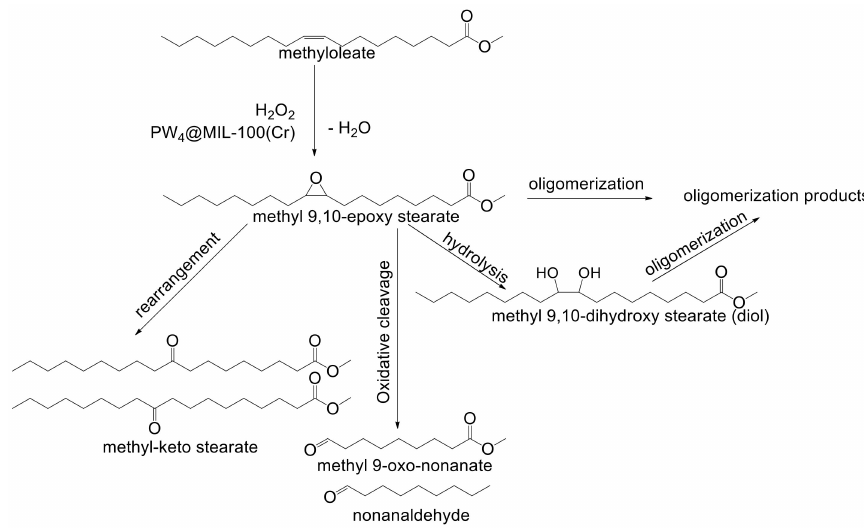
Figure 4. The proposed scheme of the reactions occurring during the epoxidation of FAMEs.